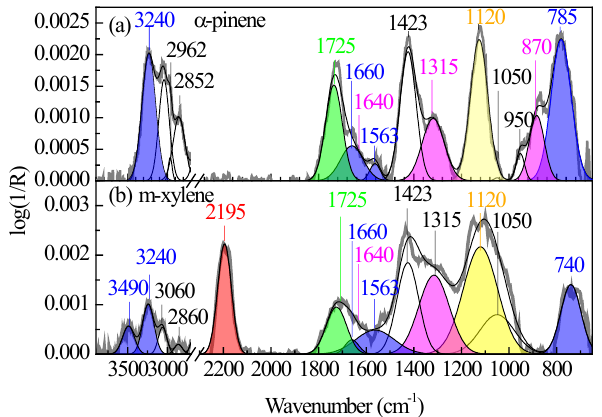
Figure 2. Infrared spectra for SOA from (a) ozonolysis of α -pinene (Exp. P11) and (b) OH oxidation of m -xylene (Exp. M15) in the presence of NH 3 . R is the abbreviation for reflectance in DRIFTS